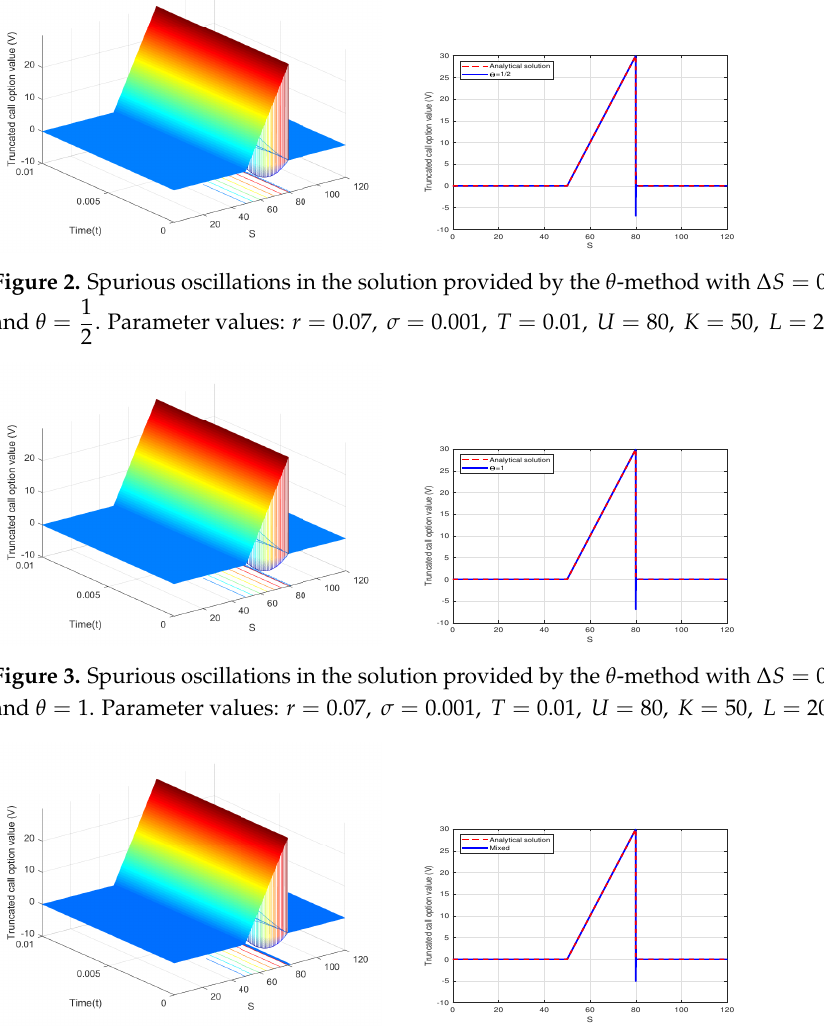
Figure 4. Spurious oscillations in the solution provided by the mixed method with ∆ S = 0.01, ∆ t = 10 − 4 . Parameter values: r = 0.07, σ = 0.001, T = 0.01, U = 80, K = 50, L = 20, S max =